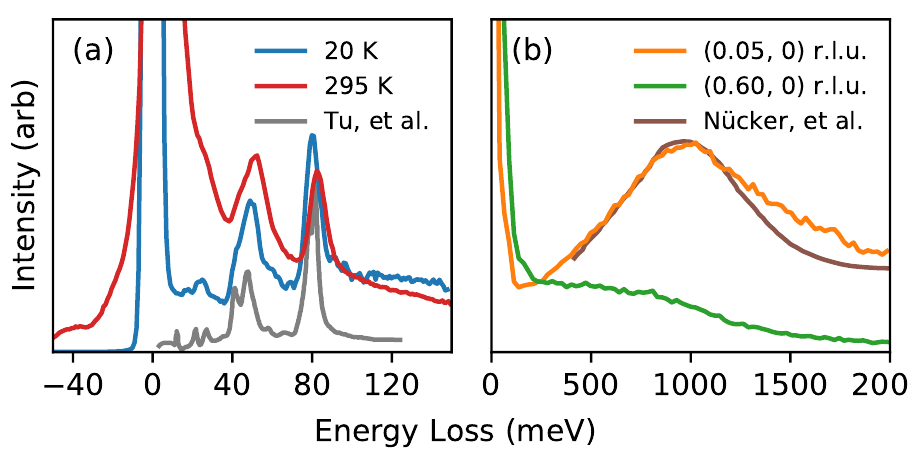
Figure 3: (a) Comparison of the M-EELS spectrum of Bi2212 at q = 0 at T = 20 K (blue) and T = 295 K (red) to the c -axis loss function measured at T = 295 K with infrared spectroscopy, reproduced from Ref. [ 46 ] (gray). The energies and spectral weights of the optical phonons